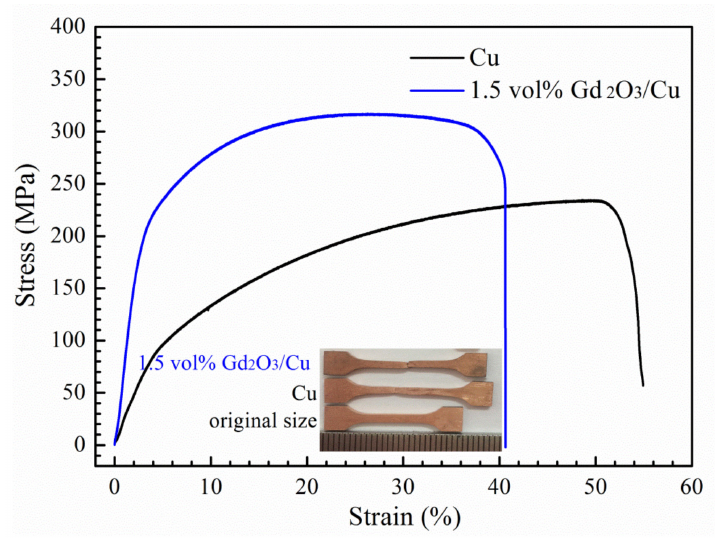
Figure 8. Tensile stress–strain curves of the nano-Gd 2 O 3 /Cu composite and pure